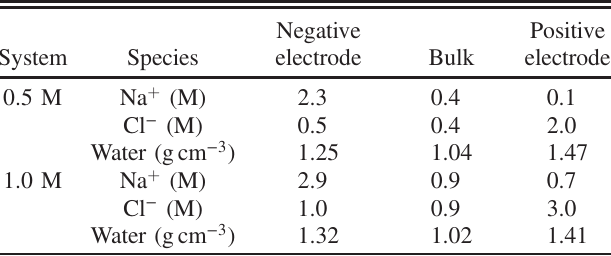
TABLE III. Cation and anion concentrations, as well as water density, in the bulk and in the electrode pores, from molecular simulation under a voltage of 1 V. The uncertainties are of order 0 . 1 M for the ion concentrations and 0 . 01 g cm − 3 for the water densities.